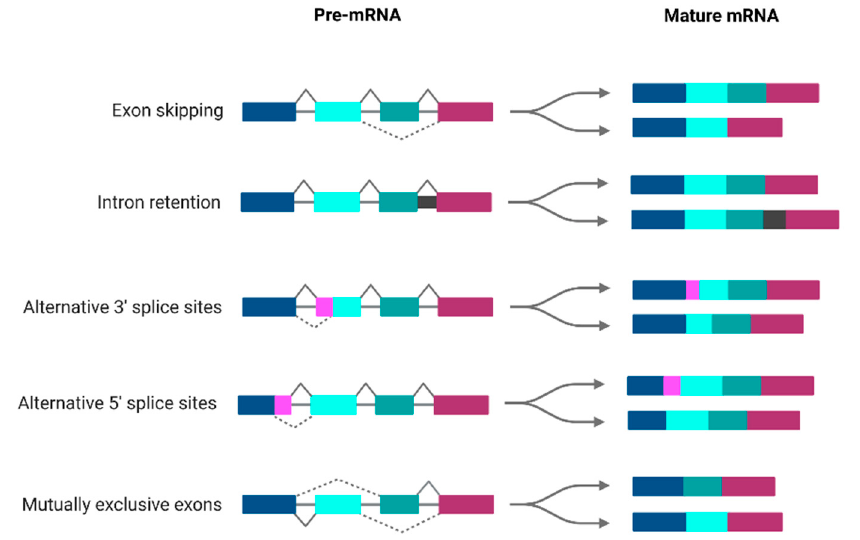
Figure 5. An overview of some of the most prominent types of alternative splicing. Exon skipping: This process removes certain exons and their adjacent introns from mRNA prior to translation. Intron retention: non-coding regions of a gene are retained in the final mRNA transcript. Alternative 5 ′ or 3 ′ splice sites: The exons join at alternative 5 ′ or 3 ′ splice sites. Mutually exclusive exons: two (or more) splicing events are not independent, but are executed or disabled in a coordinated manner.